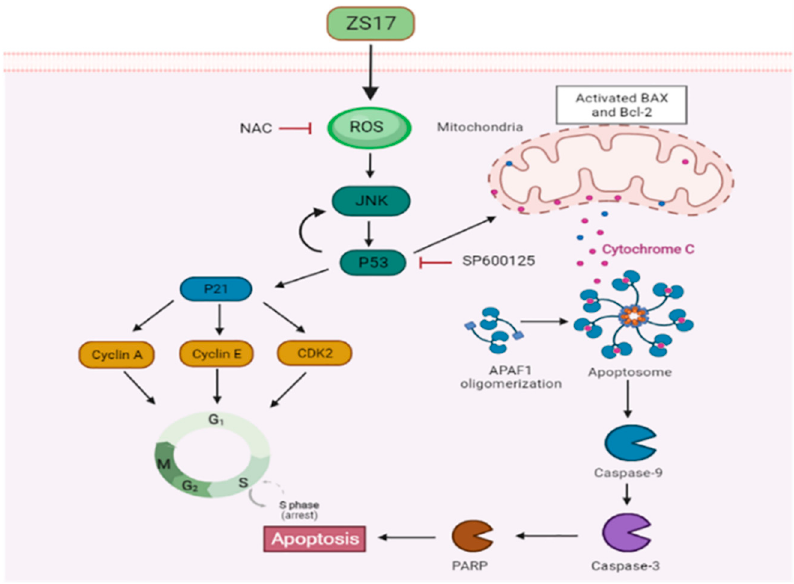
Figure 10. Inhibition mechanism of liver tumor growth by ZS17